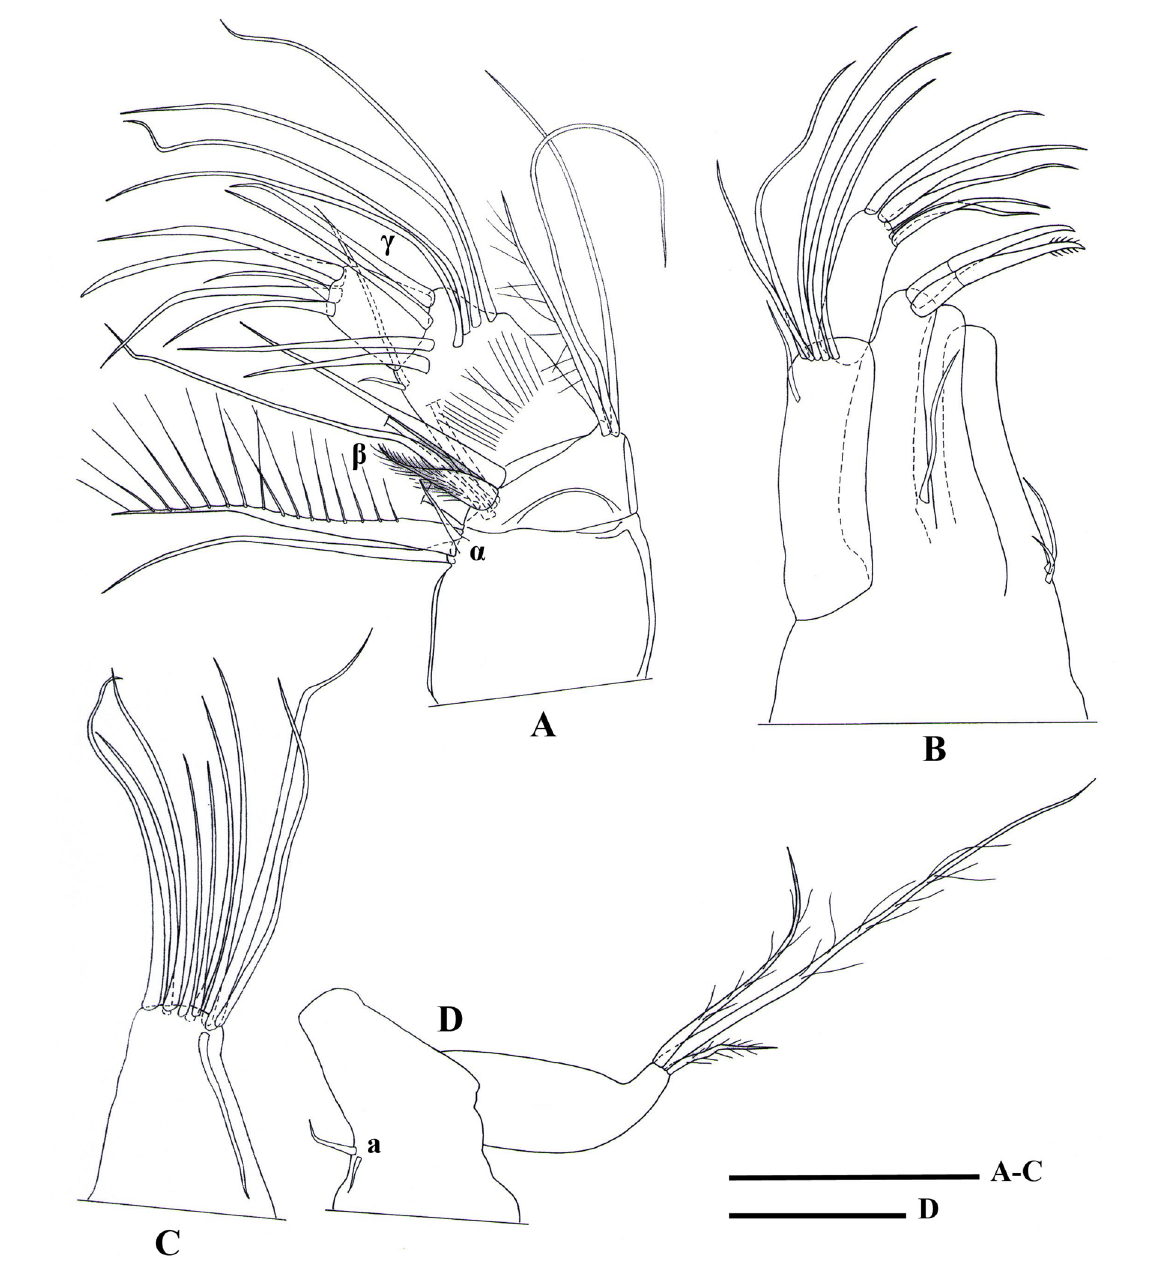
Fig. 17. Siamopsis planitia gen. et sp. nov., ♀ (MSU-ZOC.207). A . Md palp. B . Mx1. C . T1, apical setae on protopodite. D . T1. Scale bars: 50